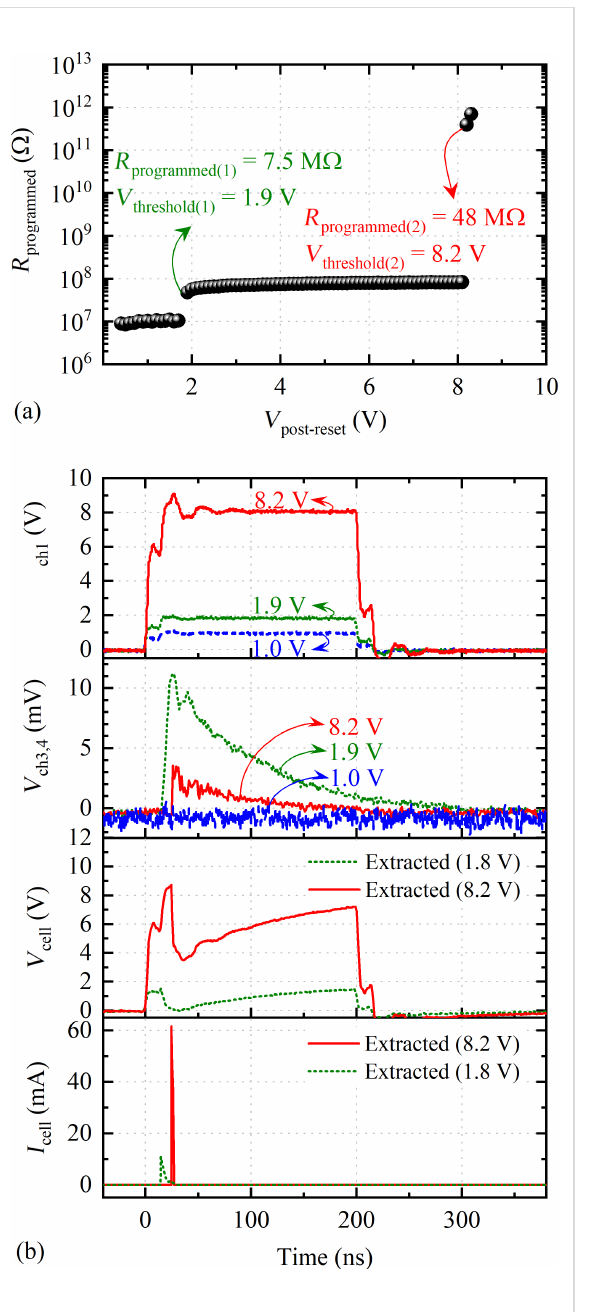
Figure 4: Repeated post-reset pulses of 200 ns duration and 0.4 to 10.0 V amplitude (with an increment of 0.1 V) applied to an amor- phous cell with L GST ≈ 470 nm, W GST ≈ 130 nm, and t GST ≈ 50 nm, initially programmed to approx. 7.5 M Ω . (a) Evolution of R programmed as a function of the post-reset pulse amplitude ( V post-reset ). (b) 1st and 2nd rows: example waveforms of applied voltage at channel 1 ( V ch1 ) and measured voltage at channel 3,4 ( V ch3,4 ) during an unsuccessful re-amorphization (blue dashed line), a successful re-amorphization at V post-reset of 1.9 V (green dotted line), and a breaking episode when electrical connections are lost at V post-reset of 8.2 V (red solid line). 3rd and 4th rows: These voltage waveforms for V post-reset of 1.9 and 8.2 V are input in the SPICE circuit simulations and the resulting cell voltage ( V cell ) and current ( I cell ) are extracted by modeling the experimental setup circuitry.